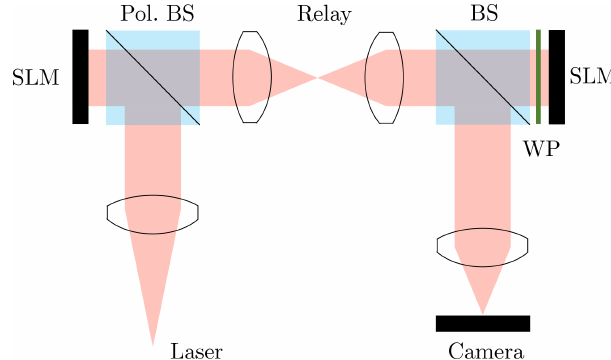
Figure 11. Illustration of the fundamental idea behind the optical processor. The laser beam is emitted on the bottom left. Two spa- tial light modulators (SLMs) are used together to input the complex function. The system uses a beam splitter (BS) and an optical relay to image one reflective SLM onto another, followed by a lens as- sembly which approximates an ideal thin lens and renders the opti- cal Fourier transform on a camera sensor. The half-waveplate (WP) before the second SLM is used to rotate linearly polarised light onto the axis of SLM action (the direction in which the refractive index switches), thus causing it to act as a phase